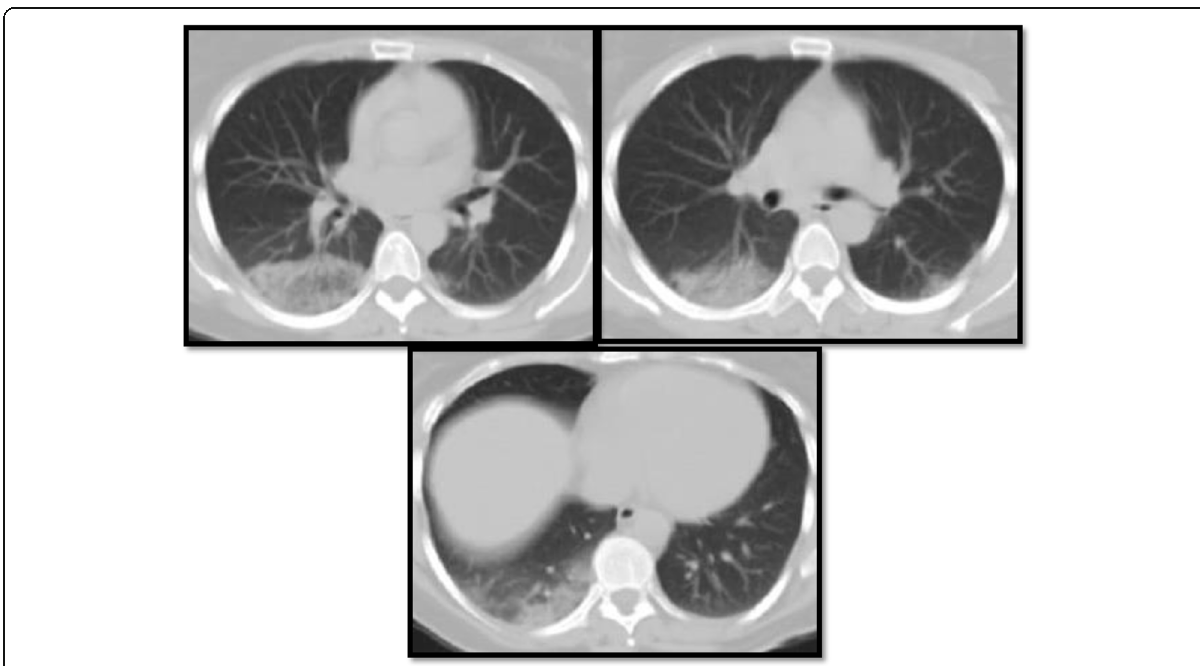
Fig. 5 A male patient, 55 years old, presented with fever and extreme fatigue. MSCT of the chest was done showing right basal coarsening of the interstitium within the ground-glass patches, which is a typical finding detected in COVID-19 viral